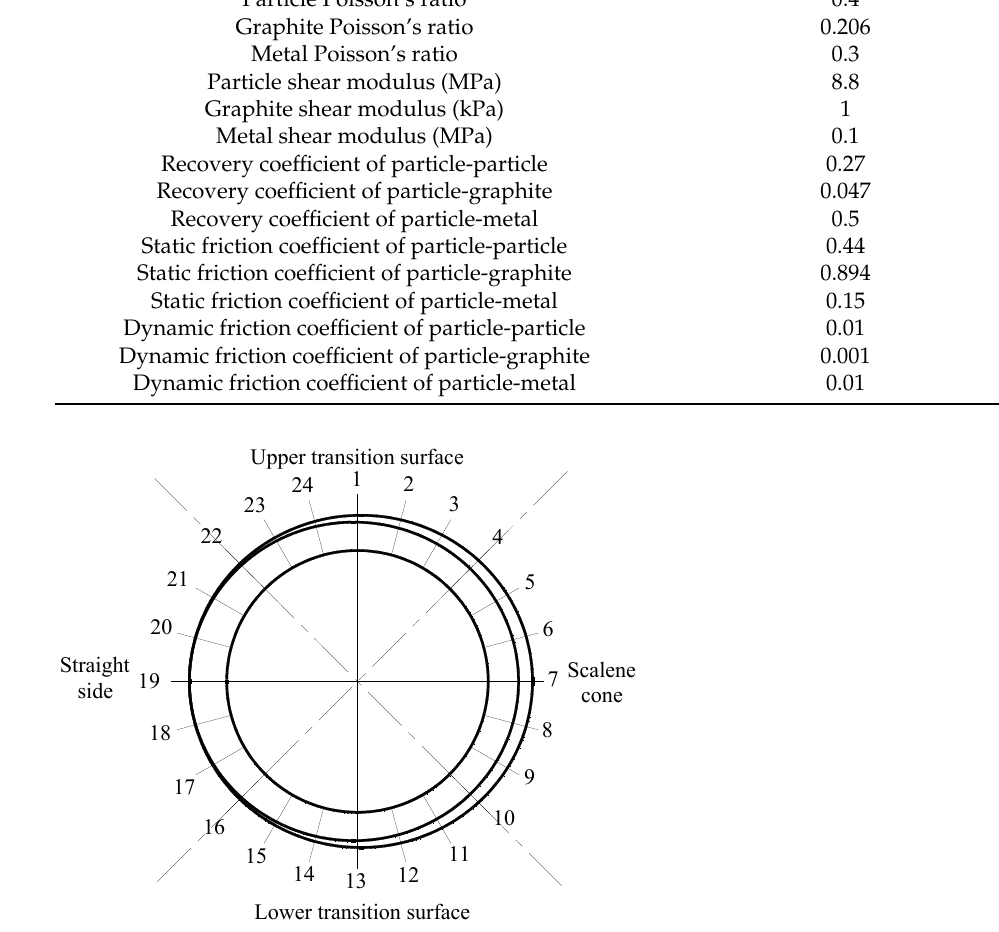
Figure 8. Map of the division of the outer ring surface of the seal and the distribution of monitoring points.